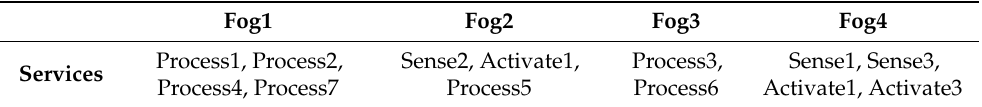
Table 8. Best service placement in the third scenario, the placement of sensors and actuators after changes in their